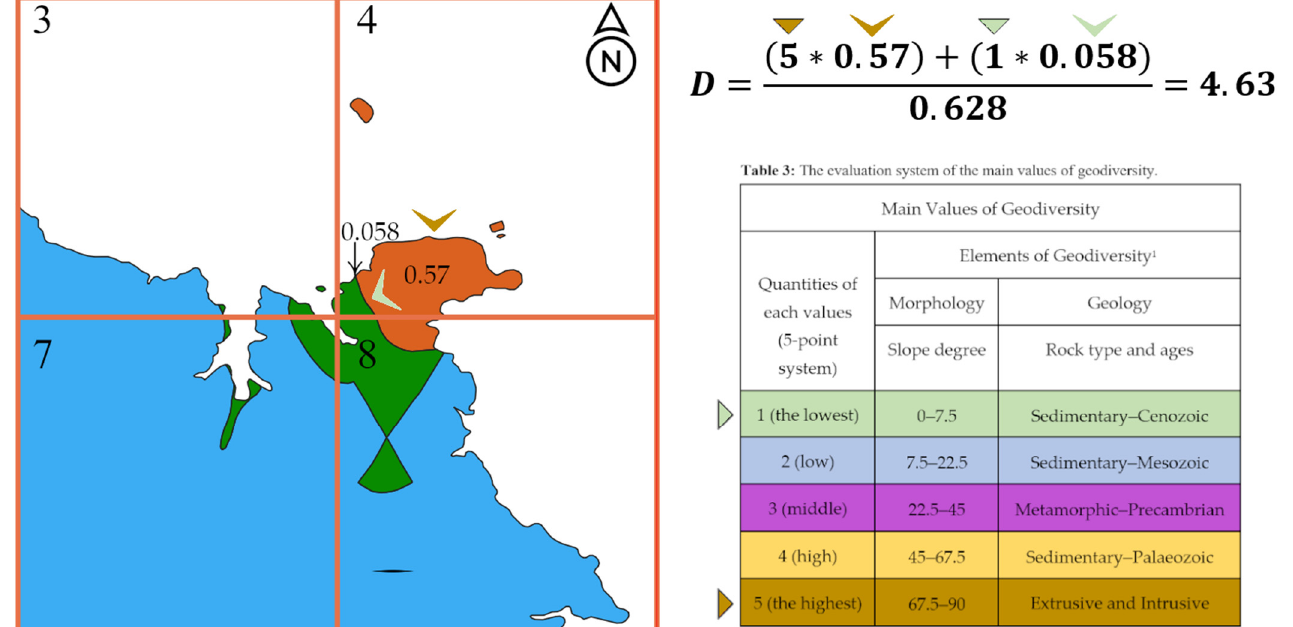
Figure 4. The visual scheme of equation. This scheme shows how to use an